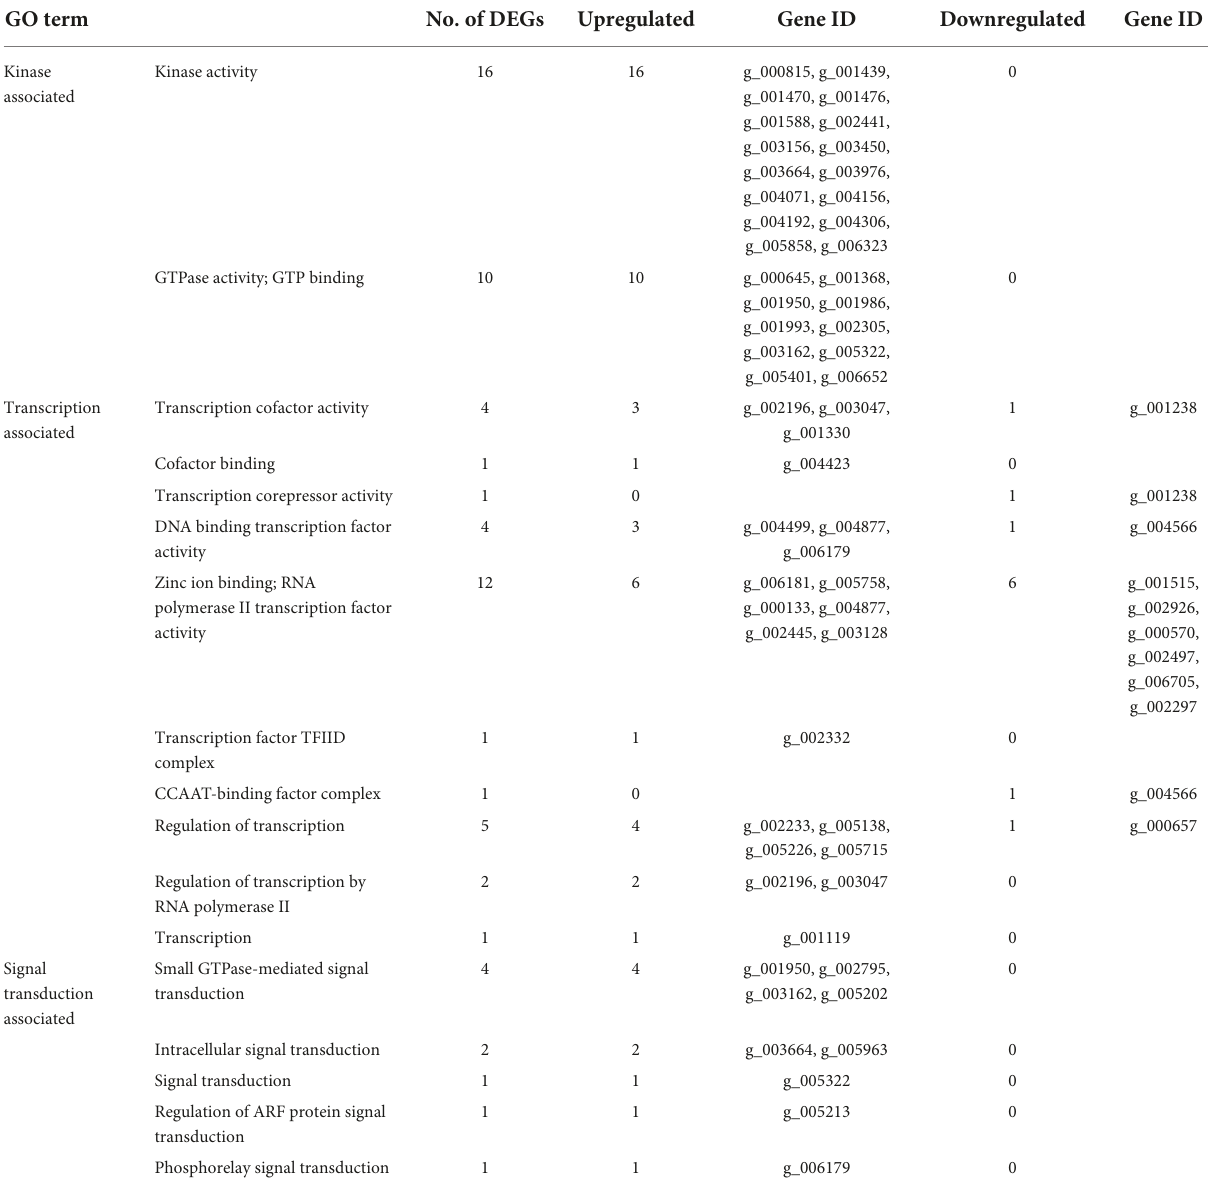
TABLE 2 Functional categories of DEGs that do not respond to mating in Ssubc2 -null mutants. Function Shared only by WT × WT and WT × (cid:49) GO term No. of DEGs Upregulated Gene ID Downregulated Gene